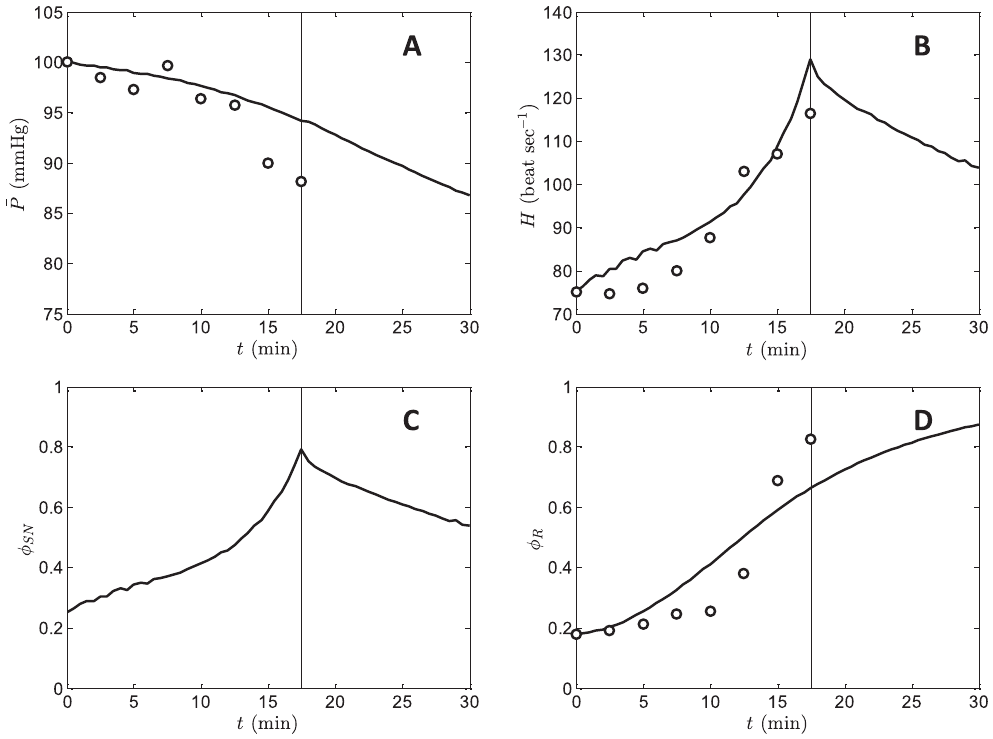
Figure 7. Simulation of system response to hemorrhage. The experimental and simulation protocol is to withdraw blood at a rate of 2% of initial total volume per minute, starting at time 0. The end of the withdrawal period, 17.5 minutes, is indicated in by dashed line in all plots. Model simulations are compared to data for mean pressure ( A ), heart rate ( B ), and plasma renin activity ( D ). Panel C plots the model- predicted sympathetic tone during the protocol. The initial condition is the same baseline condition used for the simulations of Figure 6. Data from heart rate, pressure, and plasma renin activity following graded blood withdrawal are from Quail et al. 18 with pressure and heart rate scaled as described in the